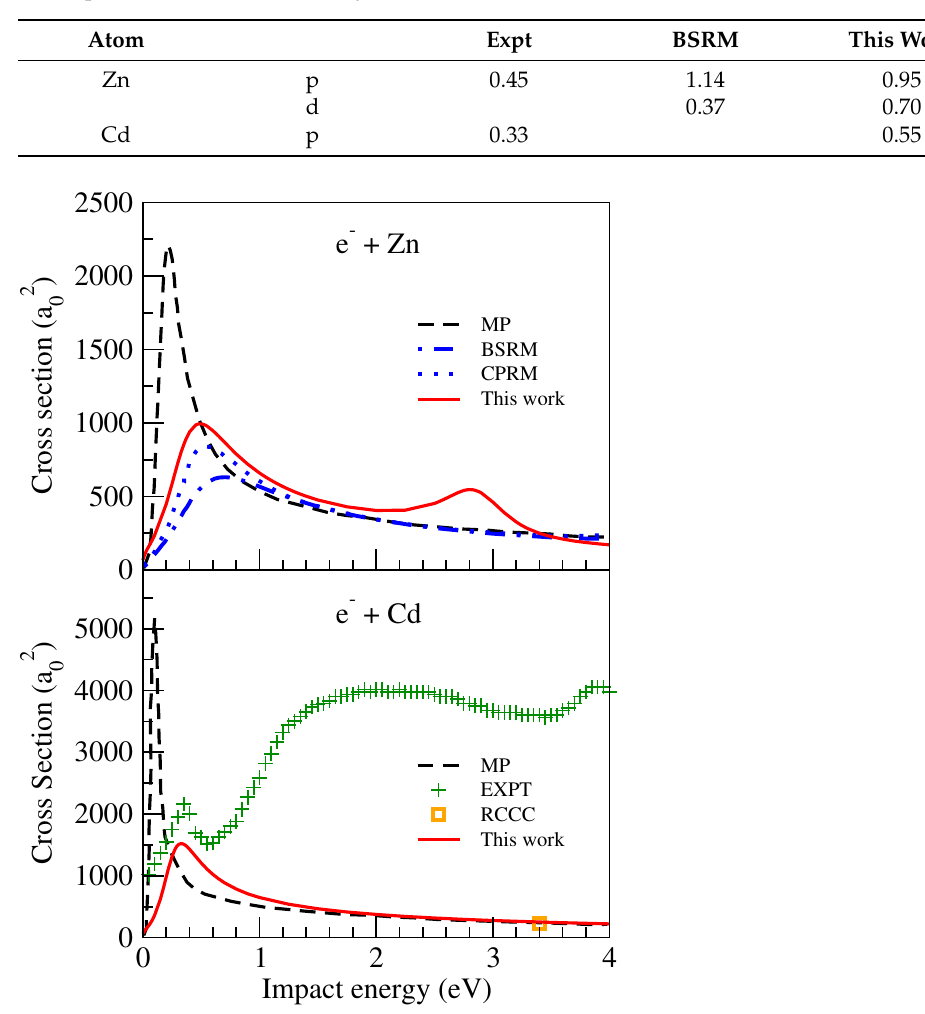
Table 2. Resonance widths in eV. The experimental values are the ones of Burrow et al. [4]; BSRM is the B-spline R-matrix of Zatsarinny and Bartschat [11].